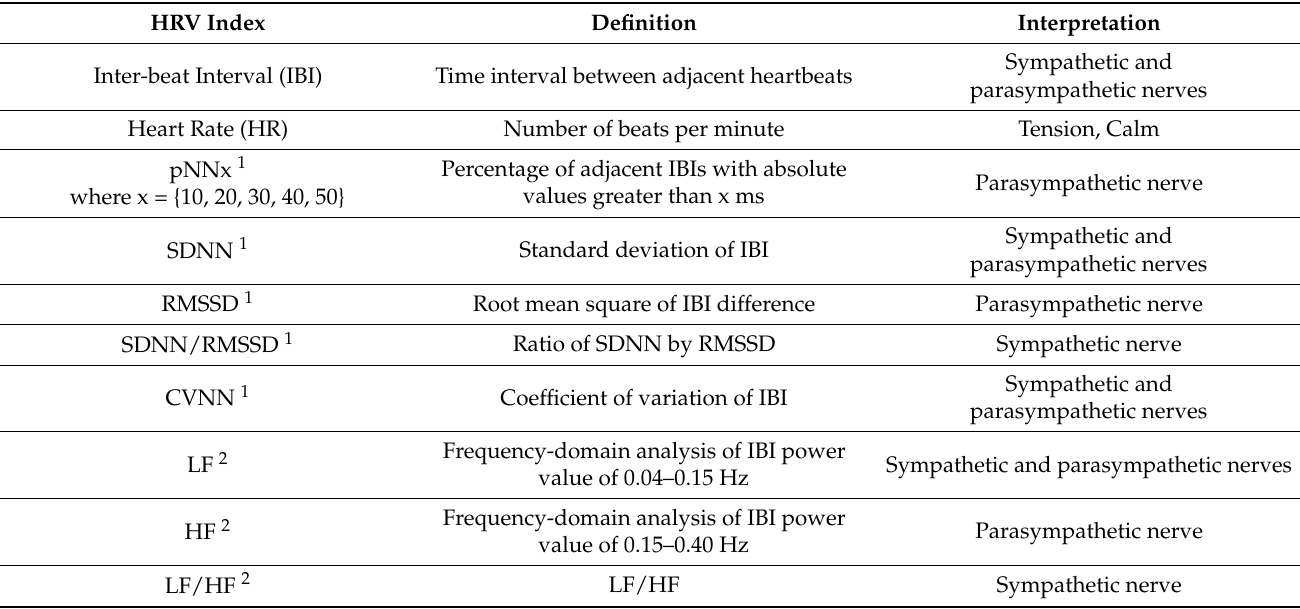
Table 2. Heart Rate Variability (HRV) indexes used in this